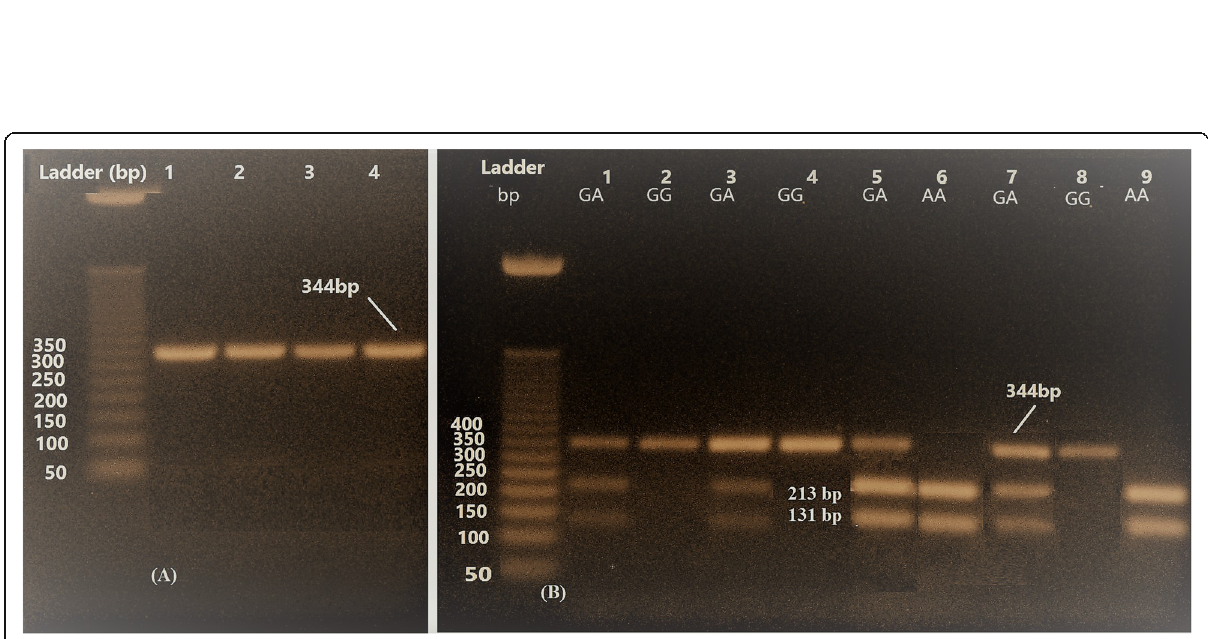
Fig. 2 Results of agarose electrophoresis of the interleukin IL-17 A rs2275913. a Represent the PCR amplified product at 344bp. b Represent the restriction fragment length polymorphism analysis reaction (RFLP). Lanes 1, 3, 5, and 7 represent the GA genotype (three bands at 344, 213, and 131 bp). Lanes 6 and 9 represents the AA genotype (two bands at 213 and 131 bp). Lanes 2, 4, and 8 represent the GG genotype (single band at 344 bp). The ladder is a 50-bp molecular-weight